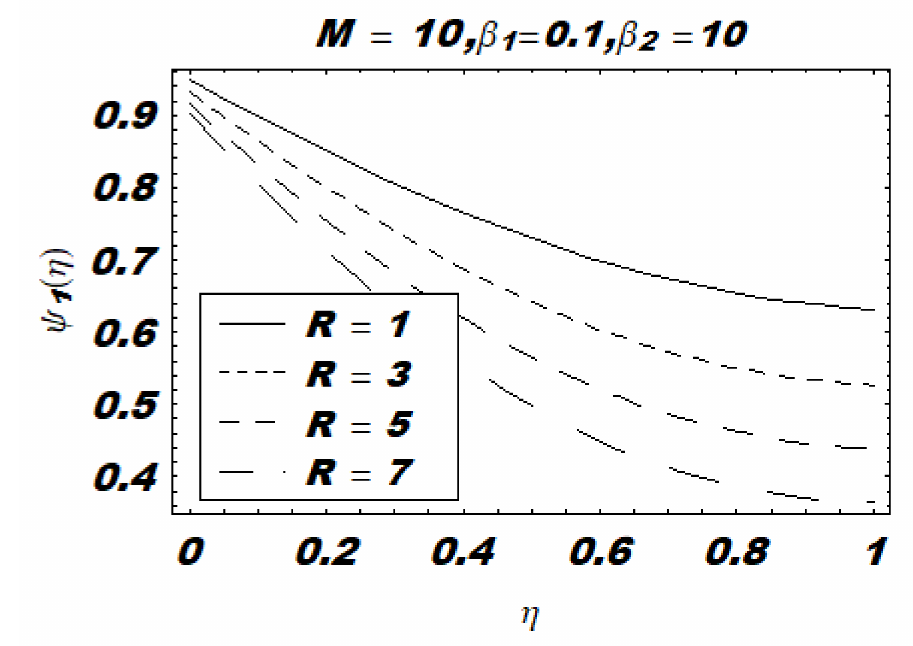
Figure 26. Similarity function ψ 1 for the circular slider.